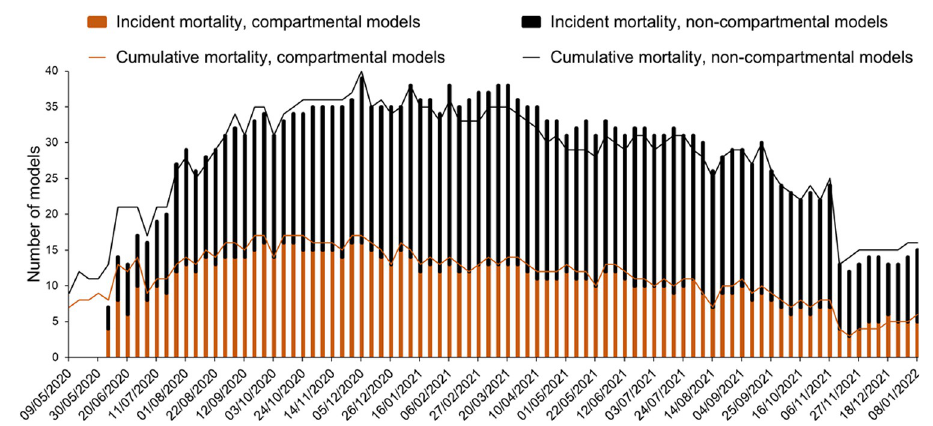
Fig 1. Number and types of models at each forecast origin for each mortality dataset.